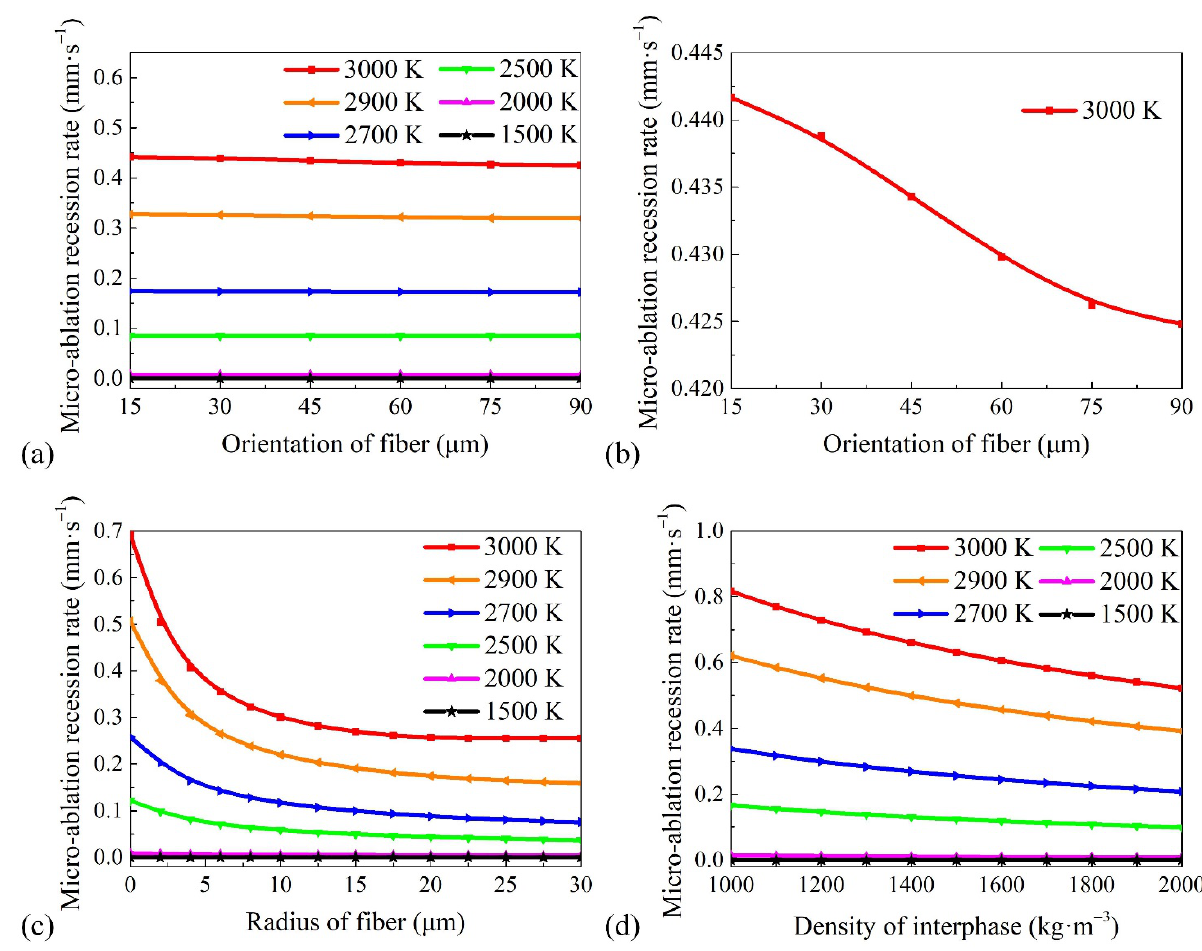
Figure 7. Variation of micro-ablation recession rate with ( a ) fiber orientation; ( b ) fiber orientation when the temperature is 3000 K; ( c ) fiber radius; and ( d ) interphase density at different temperatures ( T = 1500, 2000, 2500, 2700, 2900, 3000 K).